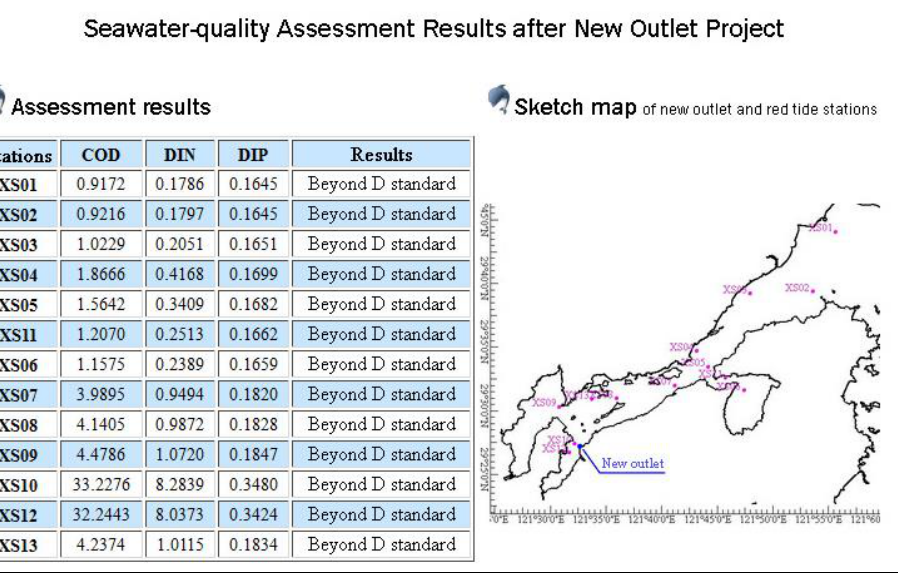
Figure 11. Seawater-quality impact assessment results displayed on the webpage.